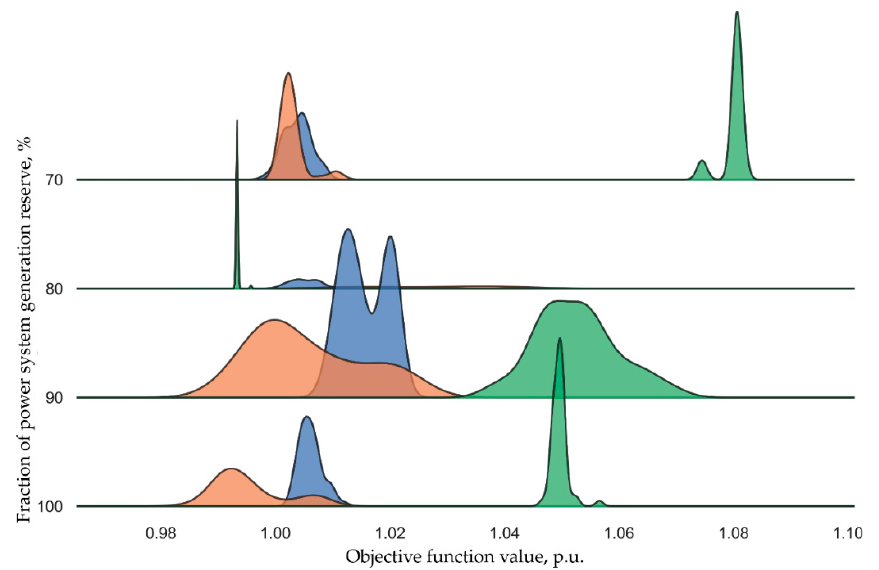
Figure 10. The probability distributions of the resultant objective function values for a number of fractions of the power system generation reserve (70%, 80%, 90%, and 100% of the initial reserve) and the degree of diversity of the list of generators to be repaired (64 generators to be repaired (blue), 32 generators to be repaired (orange), 16 generators to be repaired (green)).